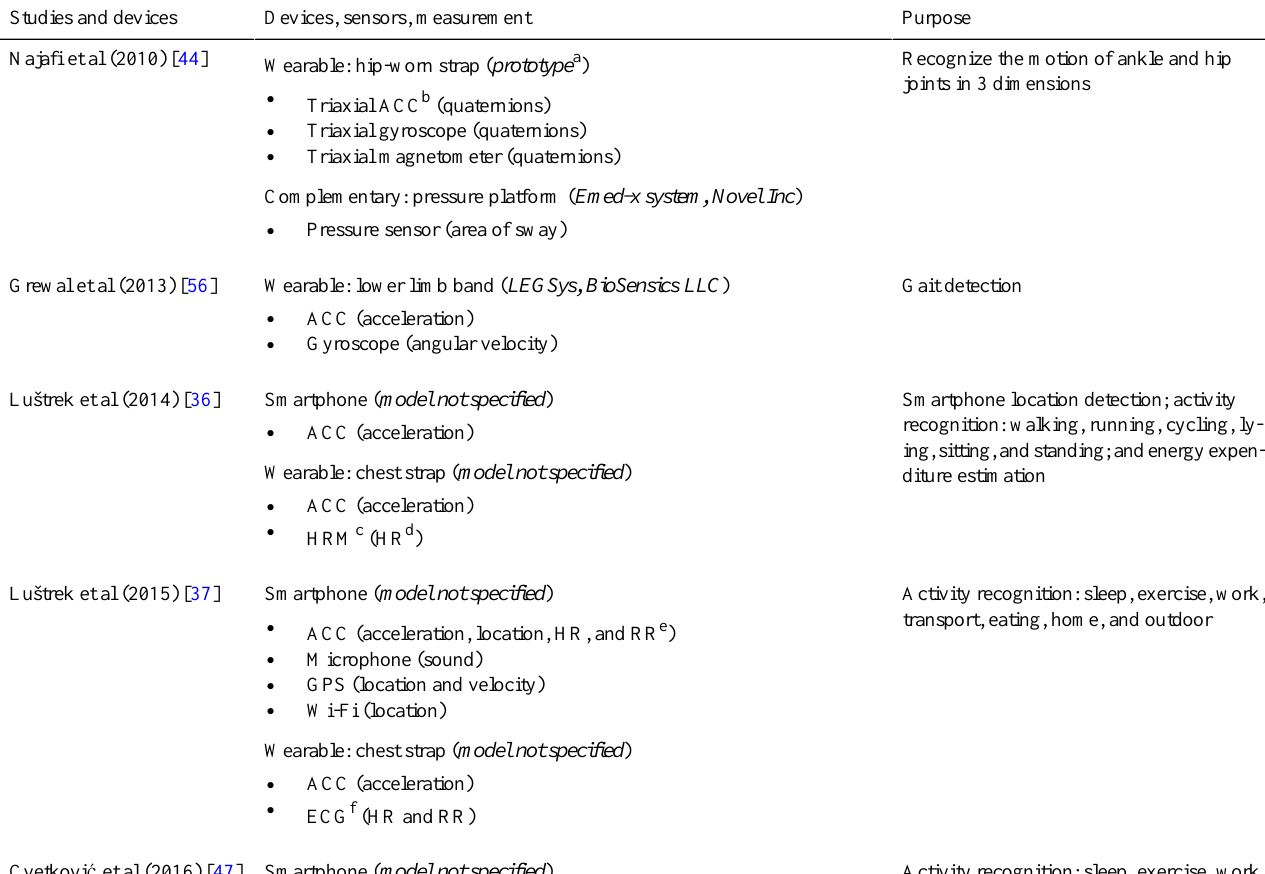
Table 2. Summary of devices used, ordered by the year of publication. PurposeDevices, sensors, measurementStudies and devices